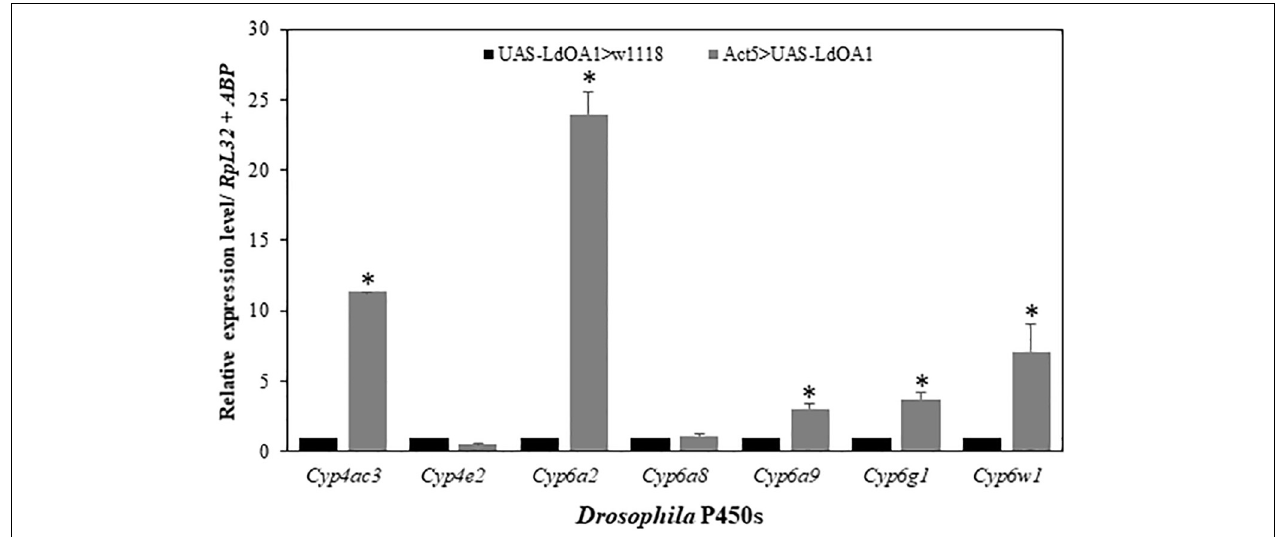
FIGURE 4 | The relative expression levels of Drosophila CYP genes in the LdOA1 overexpression flies (Act5 > UAS-LdOA1) comparing to the control flies (UAS-LdOA1 > w1118). Data were normalized to two most stable reference genes RpL32 and ABP . The 2 − (cid:49)(cid:49) CT method was used to calculate relative expression levels. The gene expression was shown as mean ± SD from three independent assays. ∗ above bars indicate significant difference according to Student’s t -test ( P < 0.05).